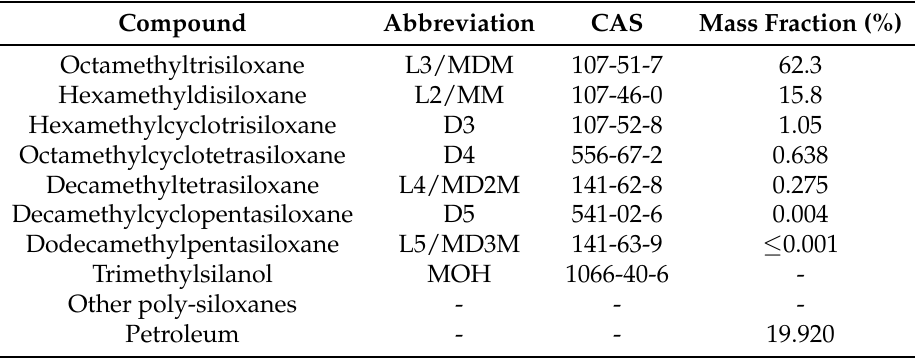
Table 6. HS-GC-MS analysis results of Experiment A, Product